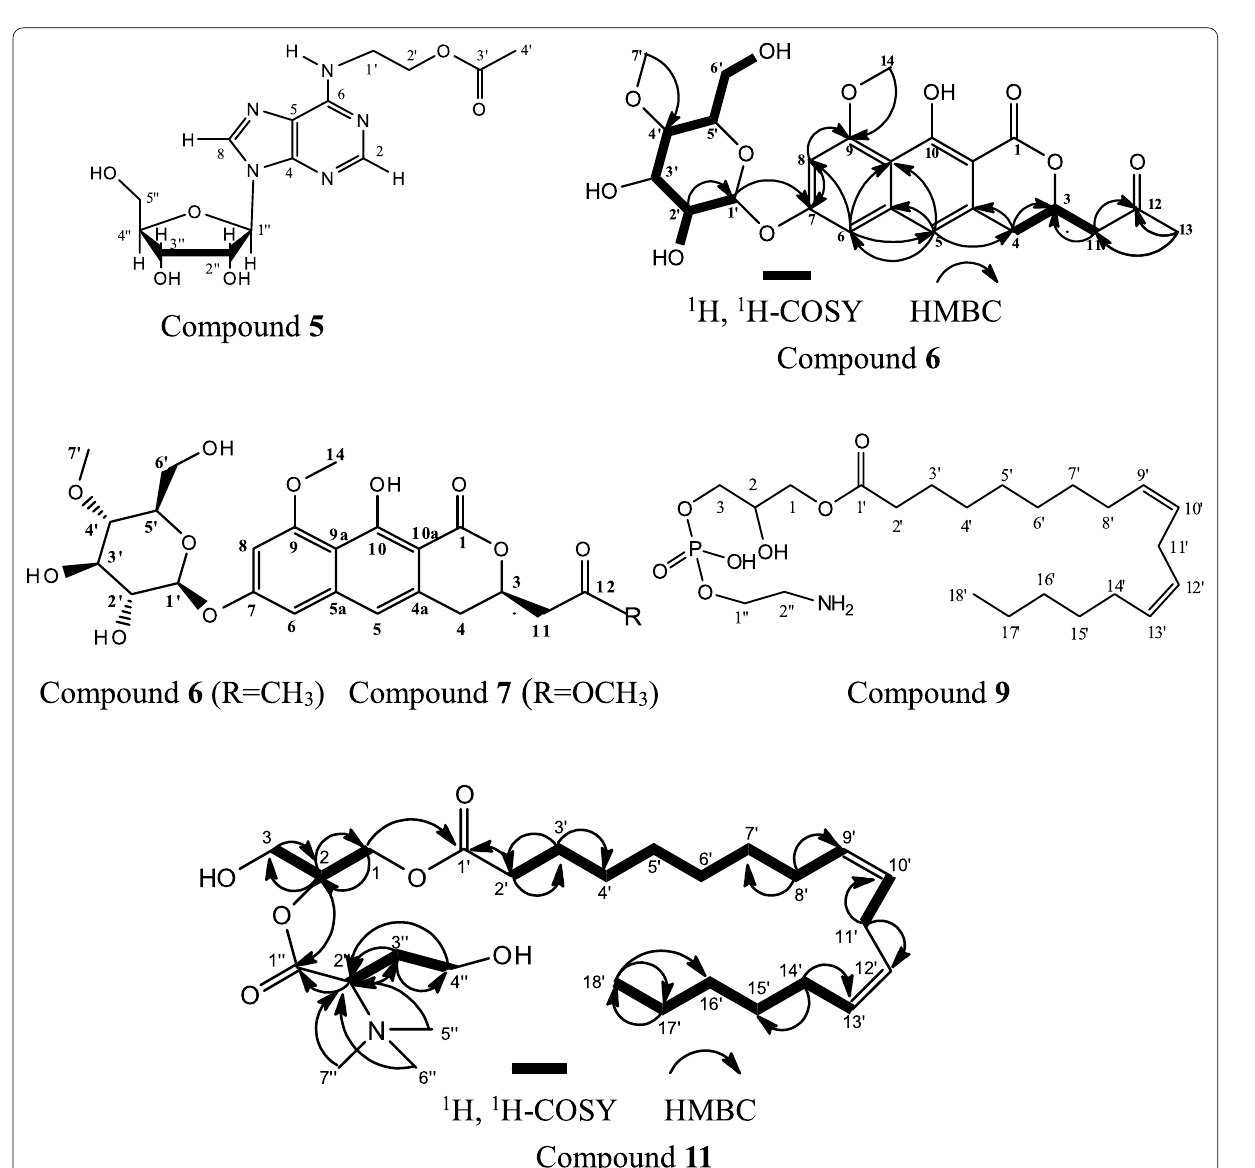
Fig. 2 Structures of compounds 5 , 6 , 7 , 9 and 11 , and HMBC and 1 H- 1 H COSY correlations of the compounds 6 , 7 and